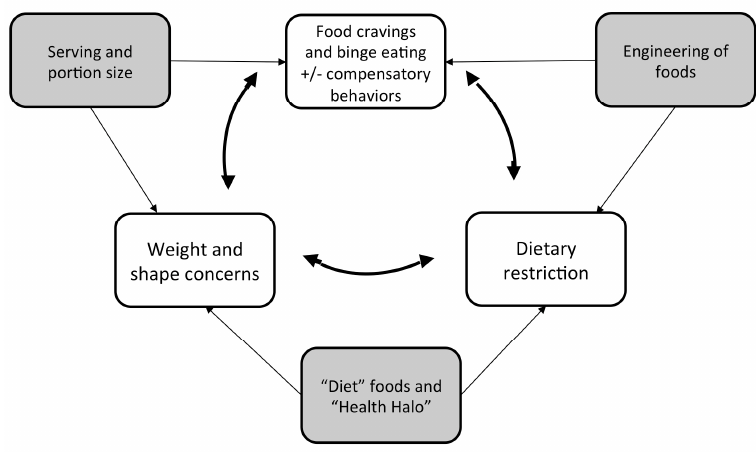
Figure 1. Food industry practices and eating disorder risk.